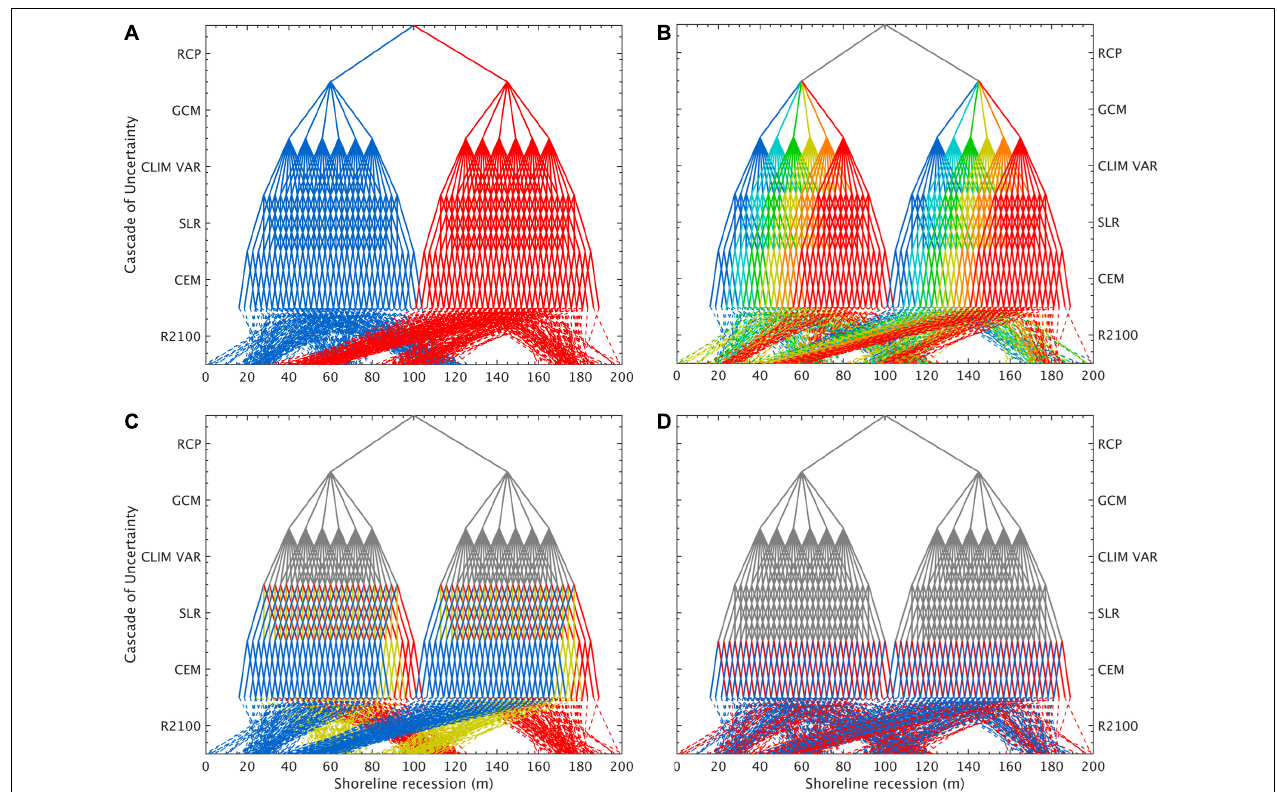
FIGURE 5 | Visualisation of the cascade of uncertainty in coastal erosion projections by 2100. The cascade is built upon SP1 simulations. From top to bottom: first layer shows the 2 RCPs, second layer shows the ensemble of 6 GCMs, third layer shows climate variability, fourth layer shows the 3 SLR percentiles, fifth layer shows the ensemble of 2 CEMs and the last layer shows the R2100 indicator (actual values displayed on the horizontal axis). (A–D) illustrate the cascade under four factorisations that highlight the uncertainty spread due to the choice of RCPs, GCMs (considering climate variability realisations), SLR percentiles, and CEMs. For the sake of visibility, we plot 720 SP1 simulations (out of 72,000) covering the full range of 2100 and distribute RCP, GCM, CLIM VAR, SLR, and CEM levels evenly in